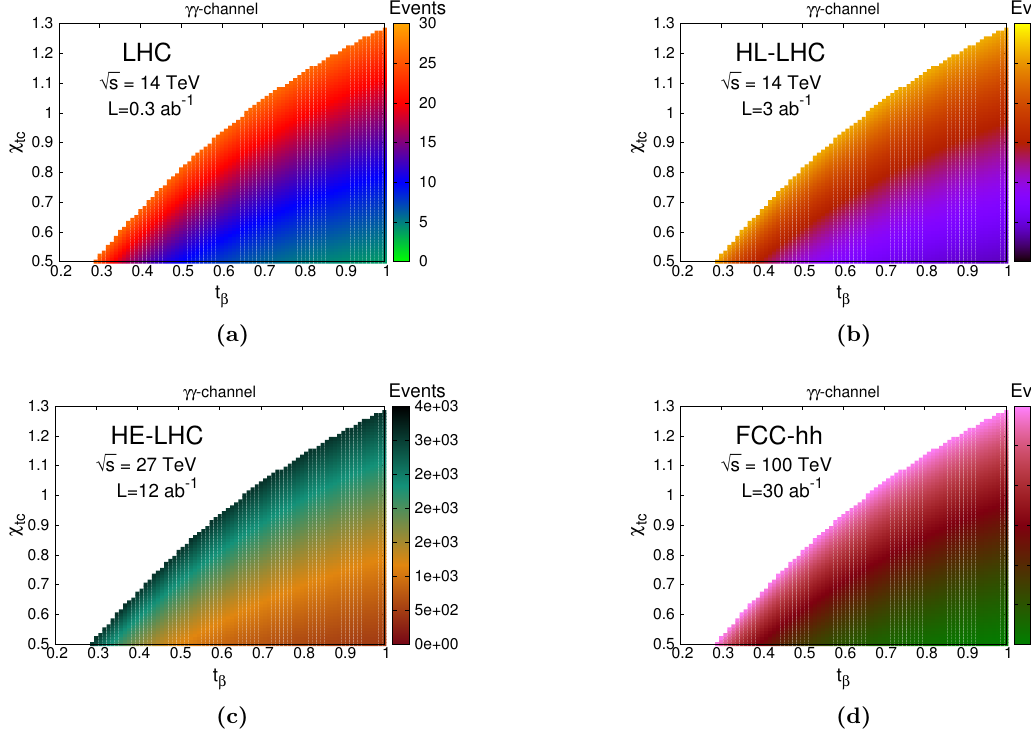
Figure 3. Number of signal events for the (cid:13)(cid:13) -channel in the t (cid:12) (cid:0) (cid:31) tc plane: (a) LHC to L =0.3 ab (cid:0) 1 , (b) HL-LHC to L =3 ab (cid:0) 1 , (c) HE-LHC to L =12 ab (cid:0) 1 and (d) FCC-hh L =30 ab (cid:0) 1